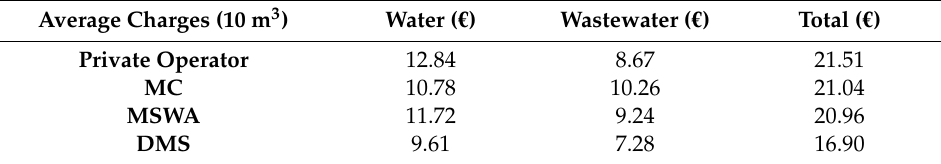
Table 5. Average monthly WSS household